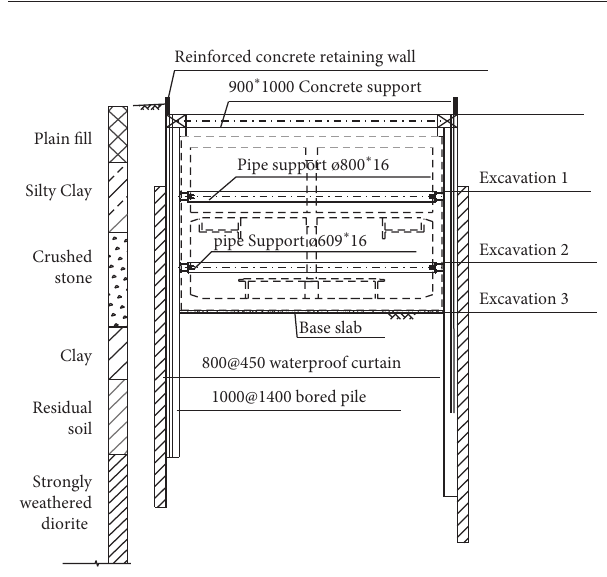
Figure 2: Foundation pit